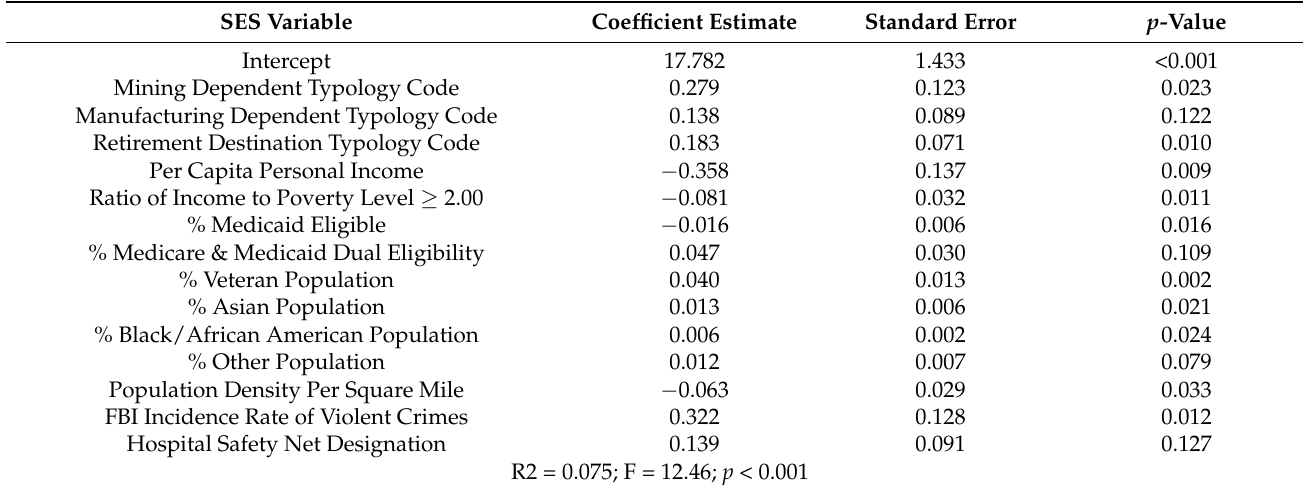
Table 2. Socioeconomic status factors and corresponding coefficient estimates, standard errors, and p -values, along with the model’s coefficient of determination, for the resulting model after AIC-based model selection for predicting 30-day risk-standardized acute myocardial infarction (AMI) mortality